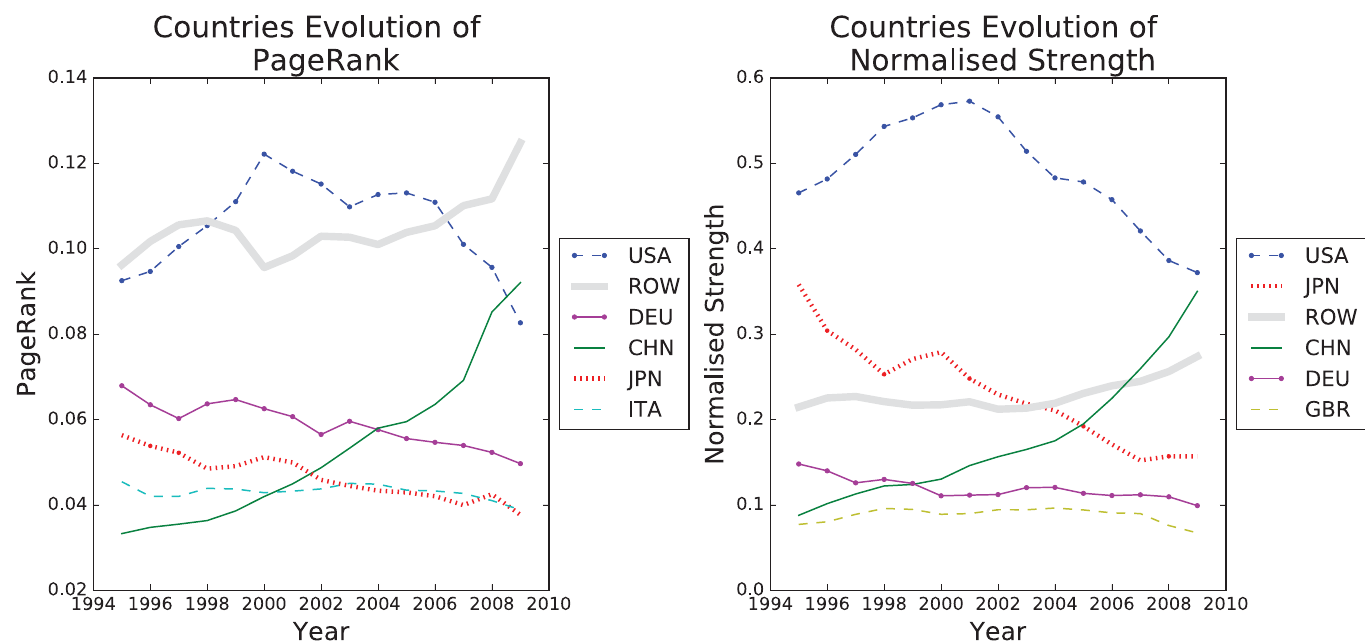
Fig 2. Evolution of the Country network over time. Top 6 ranked countries by Pagerank(left) and by normalized strength (right).